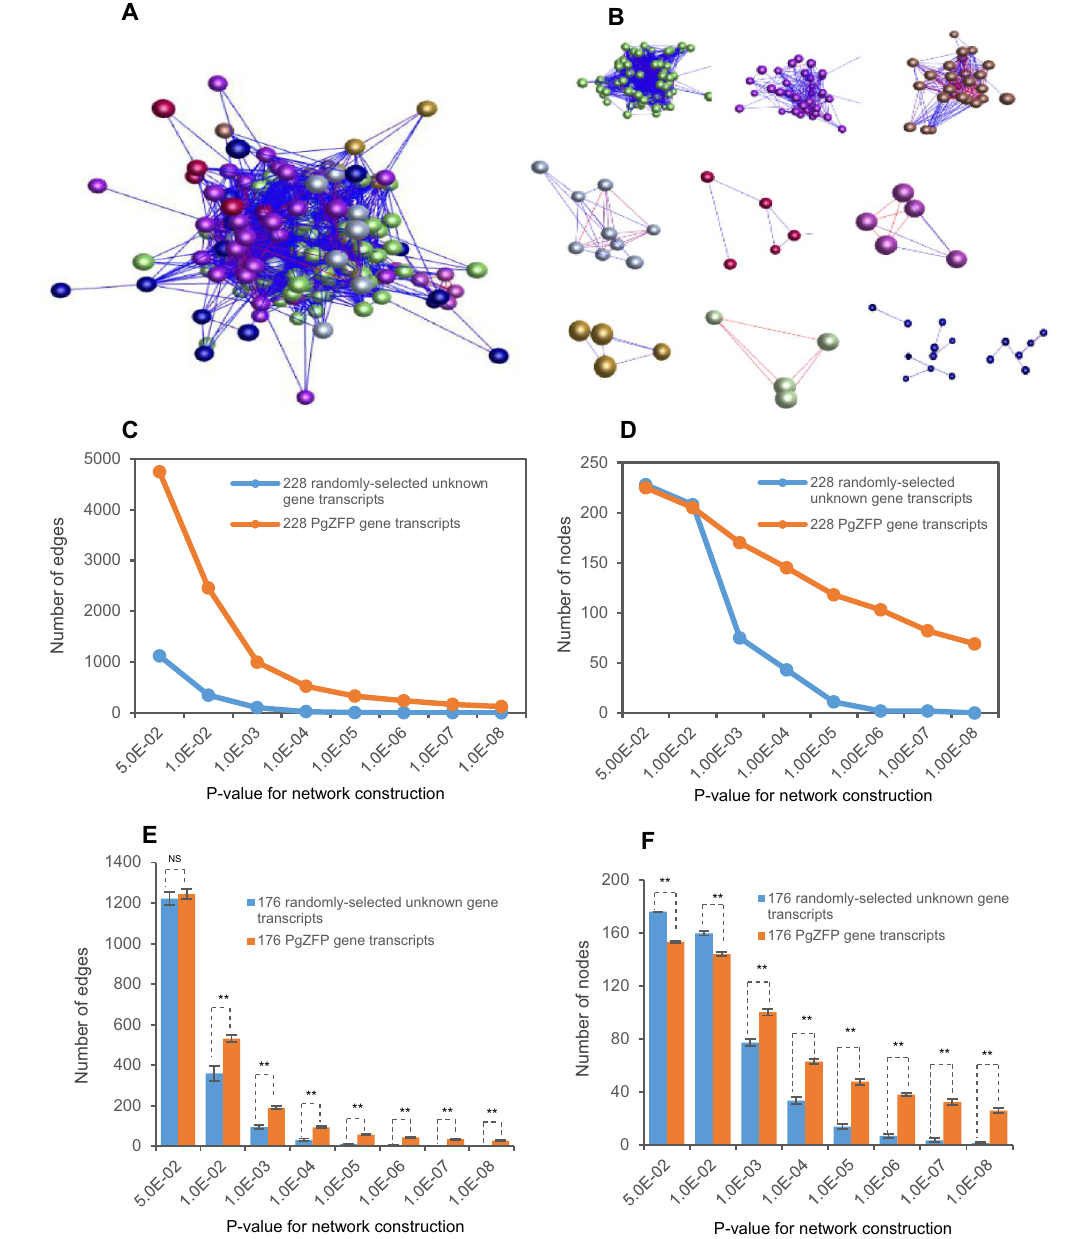
Figure 6. The co-expression network of the PgZFP gene transcripts expressed in the 4-year-old roots of 42 genotypes. ( A ) The co-expression network of the 228 PgZFP gene transcripts constructed at P ≤ 5.0E−02. It contains 228 gene transcript nodes and 4745 interaction edges. ( B ) The 12 clusters of the network. ( C, D ) Tendency of network formation at different P values: variation in numbers of nodes ( C ) and edges ( D ). ( E , F ) Statistics of the network formation tendency in numbers of edges ( E ) and nodes ( F ), with 20 replications. “**” indicates that the difference is significant at P ≤ 0.01; and “NS” indicates the difference is not significant at P ≤ 0.05. The randomly selected ginseng unknown gene transcripts were selected from Database A as